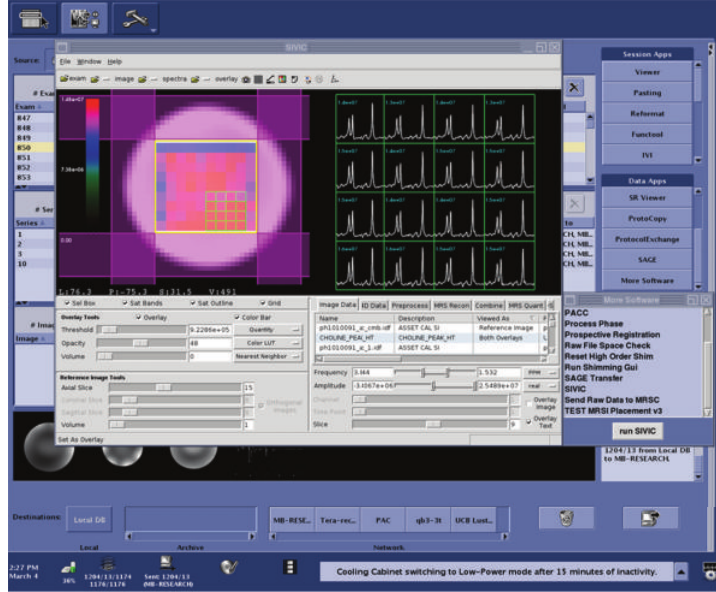
Figure 7: Phantom MRS data reconstructed and quantified using the SIVIC GUI on a 7T GE scanner console. The right panel shows spectra from the 16 selected voxels. The voxels are spatially referenced to the image in the left panel. The color overlay on the left is a metabolite map representing the choline peak height. The blue text above the spectra gives the exact value of the current overlay for each